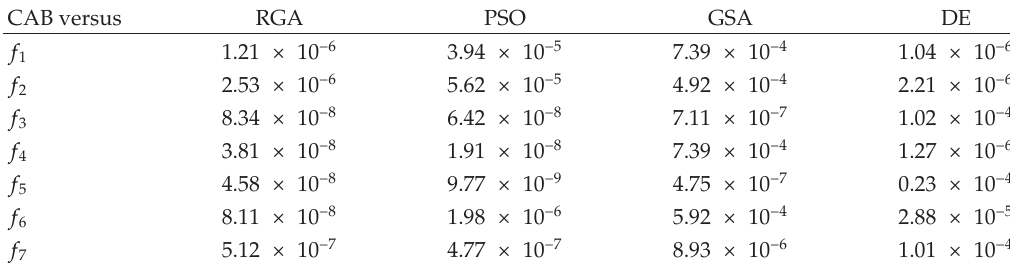
Table 4: P values produced by Wilcoxon’s test comparing CAB versus RGA, PSO, GSA, and DE over the “average best-so-far” values from Table